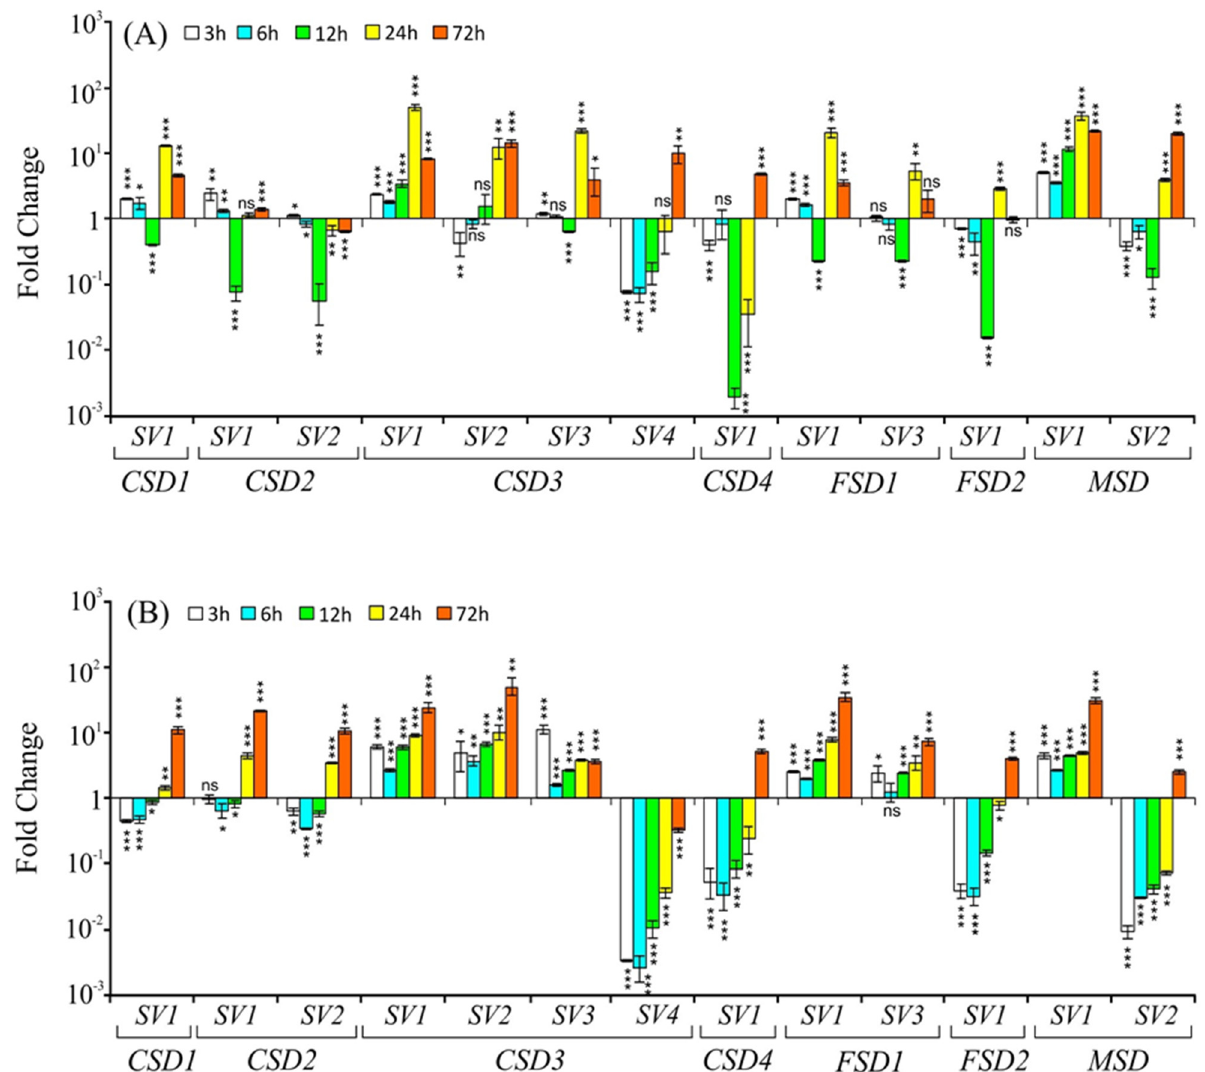
Figure 3. Relative transcript levels (on Y -axis) of CSDs , FSDs , and MSD splice variants (indicated by numbers on X -axis) in response to salt stress (150 mM NaCl), in shoot ( A ) and root ( B ) tissue at 3 h, 6 h, 12 h, 24 h, and 72 h after the stress treatment. Transcript levels in control and treated samples were normalized against OsActin, and fold change (relative expression) was estimated as per Schmittgen and Livak [28] using Actin as a reference gene. The experiment was carried out with two independent biological replicates (each sample had three technical replicates), repeated twice, and data are presented as mean transcript level ± SD. The significance level is indicated by * p < 0.05, ** p < 0.01, *** p < 0.001, and ns (no significant difference).